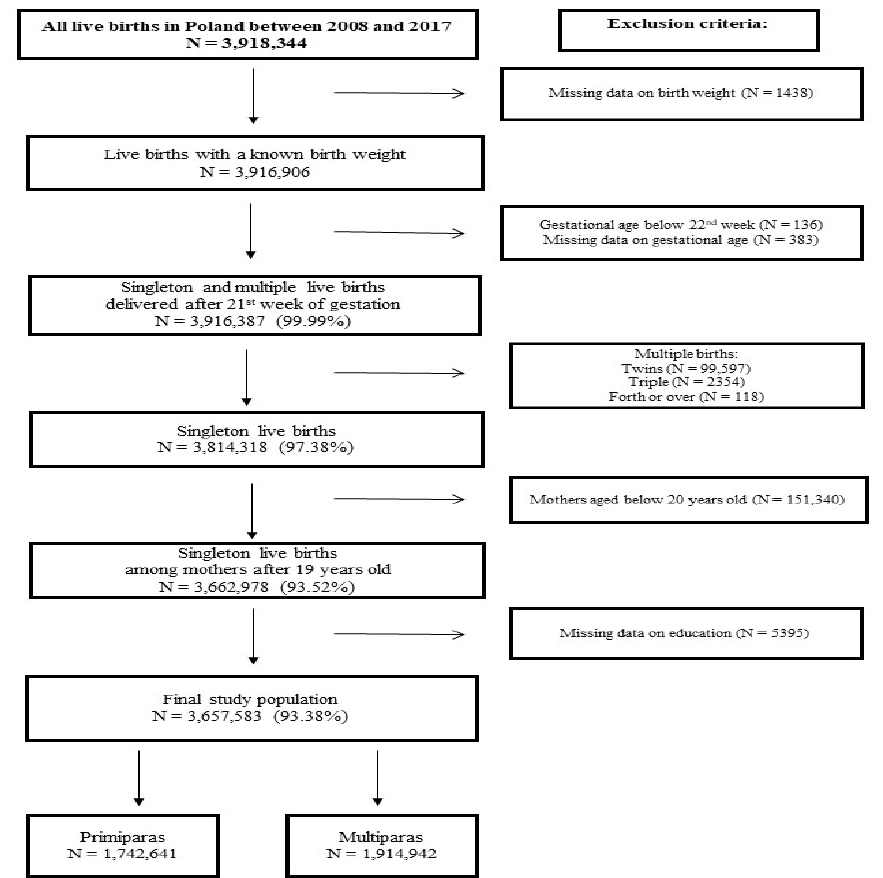
Figure 1. Flow diagram of the study.